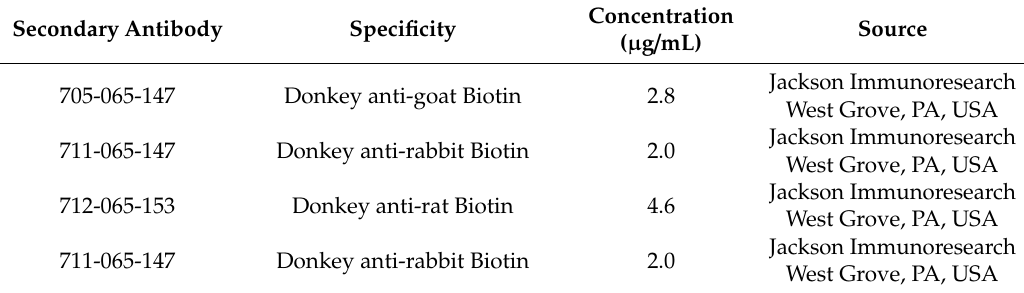
Table 2. Secondary antibodies used for immunohistochemical staining for IL-1 β , ICAM-1, F4 / 80 and HO-1. Source and used concentrations of the antibodies are